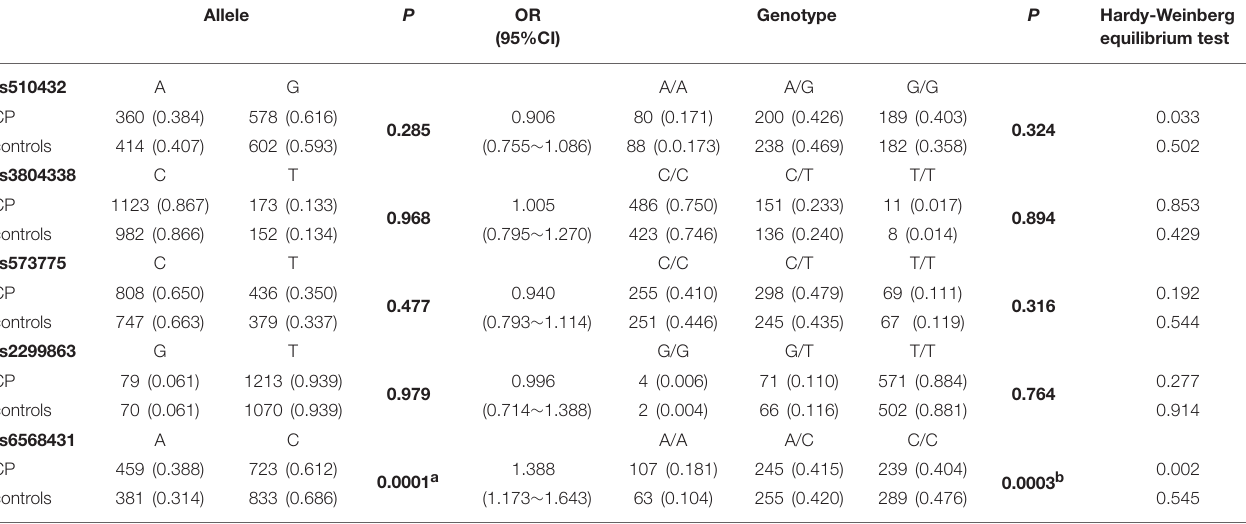
TABLE 2 | Allele and genotype frequencies of ATG5 genetic variants in CP ( n = 715) and controls ( n = 658). Allele P OR Genotype P Hardy-Weinberg (95%CI) equilibrium test